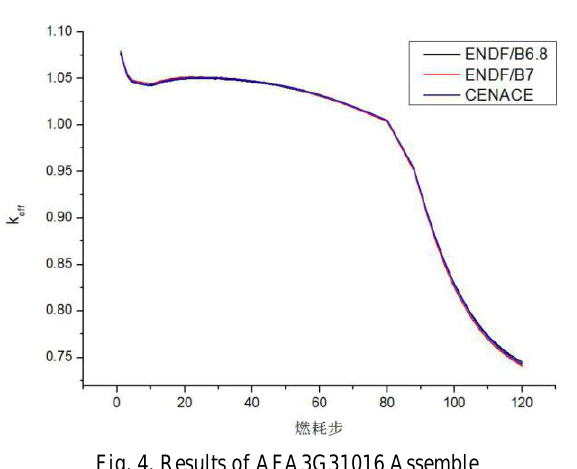
Fig. 3. Results of AFA3G31000 Assemble